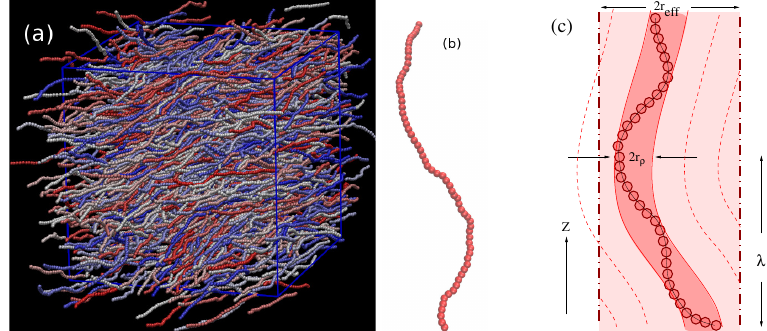
Figure 4. ( a ) Snapshot of a system of semiflexible polymers with length N = 32, stiffness (cid:101) b = 100, at concentration ρ = 0.6 (with nematic order parameter S ≈ 0.9). Chains are shown in different colors so that they can be better distinguished visually; ( b ) Typical conformation of a semiflexible polymer in the nematic phase ( N = 64, (cid:101) b = 16, ρ = 0.4, S ≈ 0.9); ( c ) Schematic description of nematic order as effective cylindrical confinement: each chain has its own cylindrical bent tube of diameter 2 r ρ defined such that it contains only monomers from the considered chain. This tube roughly follows the contour of this macromolecule, which shows long wavelength undulations with a typical wavelength given by the deflection length. The typical amplitude of these deflections is of the order r eff defining a cylinder (the straight axis of this cylinder is oriented along the director of the nematic phase). This cylinder contains not only a single bent tube, but rather is densely filled by a whole bundle of neighboring tubes whose deflections are strongly correlated. Reproduced from [42] with permission from the